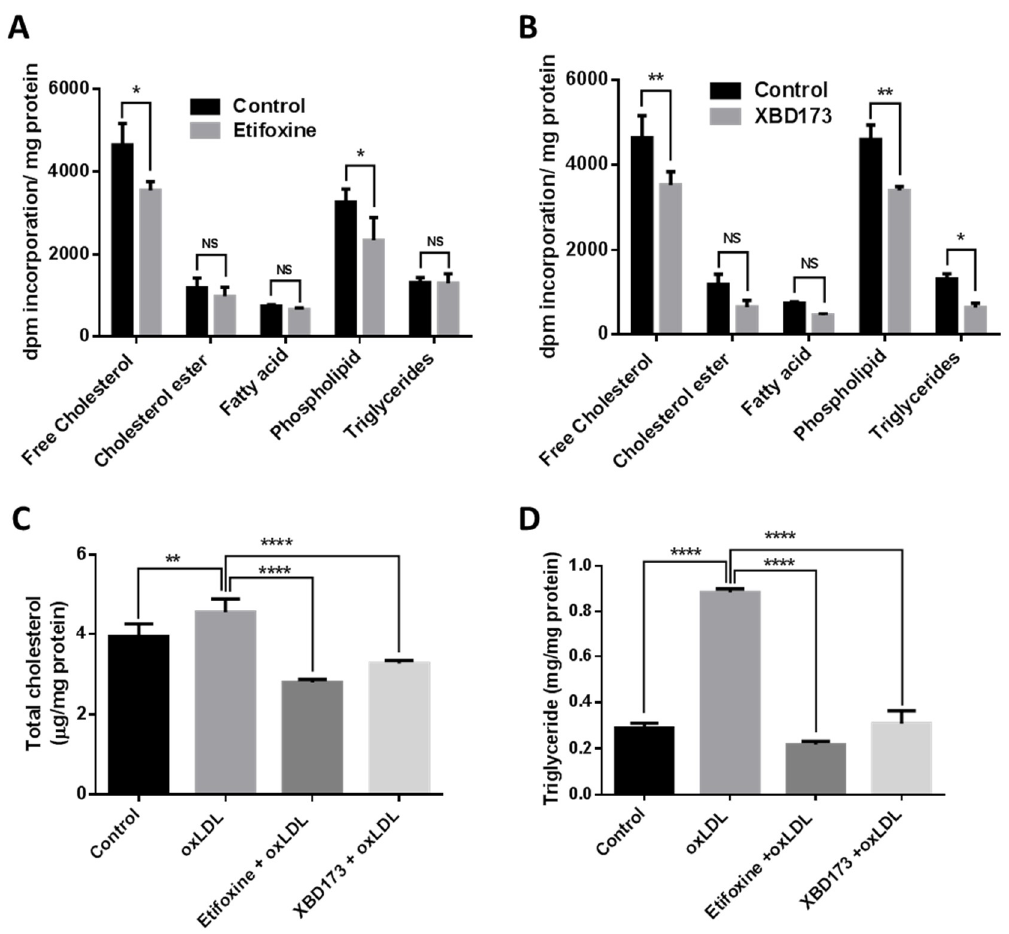
Figure 3. TSPO ligands modified the lipid phenotypes in RF/6A cells. The effect of TSPO ligands (( A ): Etifoxine, 20 µ M; ( B ): XBD173, 25 µ M) were studied on disintegrations per minute (dpm) incorporation/mg total protein of [ 14 C]acetate (1 µ Ci/mL) into free cholesterol, cholesteryl ester, fatty acid, phospholipid and triglycerides compared with the 0.1% vehicle control. These TSPO ligands also were applied to RF/6A cells to quantify the total cellular cholesterol ( C ) after the excitation of oxLDL and with their vehicle control. Similarly, it was applied to quantify triglycerides level. All data was represented as mean ± SD and analysed by Two-way ANOVA ( A , B ) and one-way ANOVA ( C , D ) followed by Bonferroni test. Three independent experiments were performed and the value of statistical were pointed as * p ≤ 0.05; ** p < 0.01, **** p < 0.0001. NS: non-significant.